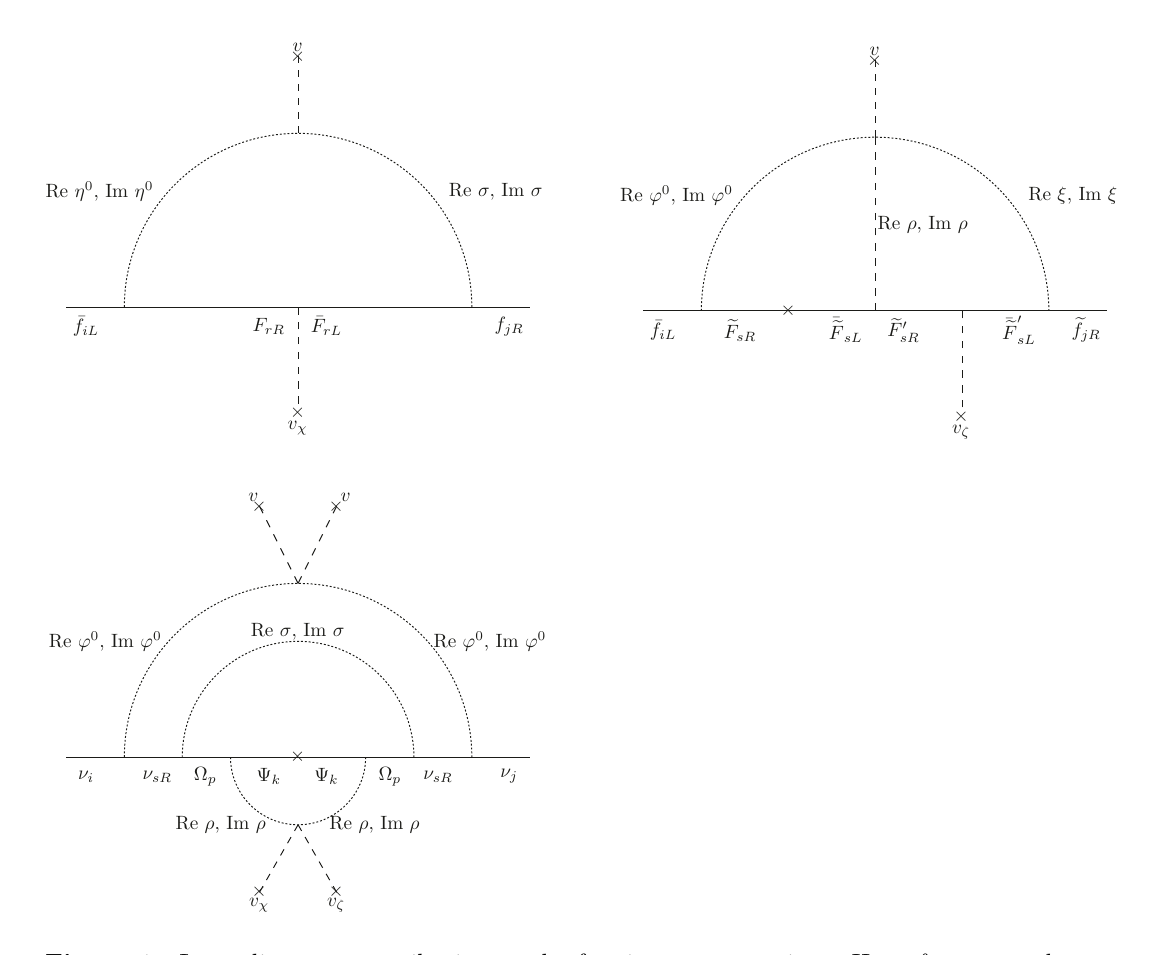
Figure 1 . Loop diagrams contributing to the fermion mass matrices. Here f iL = u iL , d iL , e iL ( i = 1 , 2 , 3 ), f R = u 2 R , d 3 R , l 2 R , l 3 R , e f R = u 1 R , d 1 R , d 2 R , l 1 R . The electroweak singlet charged exotic fermions, see (2.9), are denoted by F rR , F rL , e F sR and e F sL , where r = 1 for quarks, r = 2